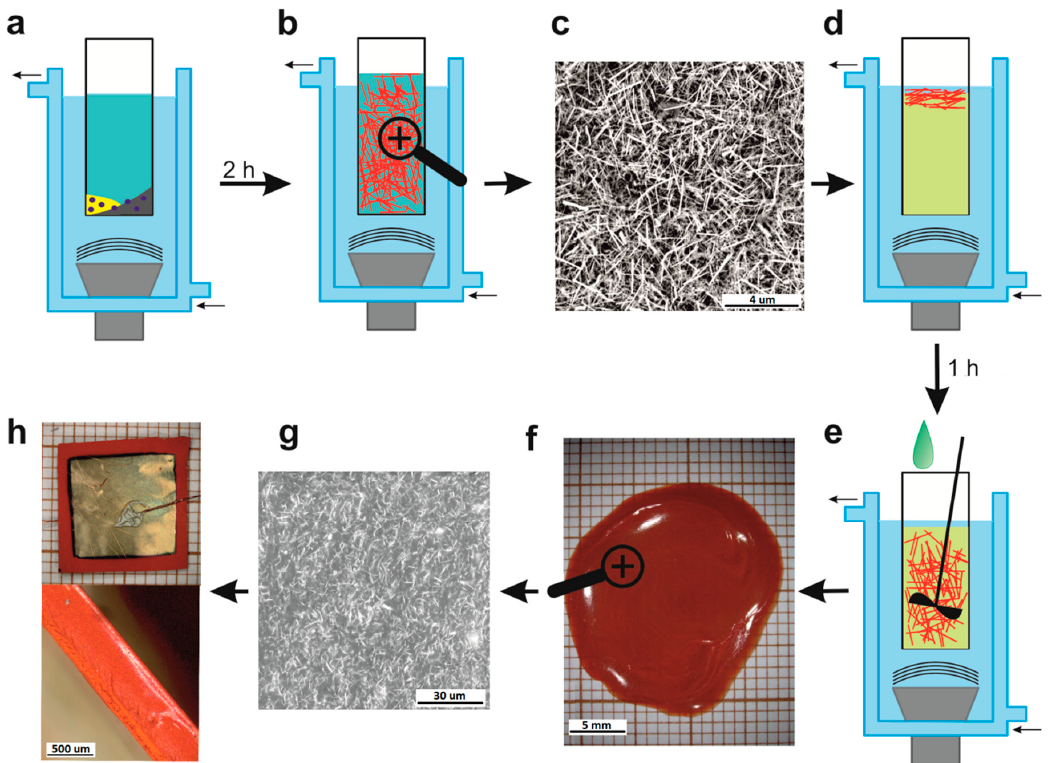
Figure 1. Scheme of sonochemical preparation of the epoxy resin/antimony sulpho-iodide (SbSI) nanowire composite and epoxy resin/SbSI nanowire generator/sensor assembly. The steps are as follows: ( a ) initial elements (sulphur, antimony, and iodine) are sonicated in an ampoule filled with ethanol; ( b ) SbSI nanowires are obtained after 2 h of sonication; ( c ) a typical scanning electron microscopy (SEM) micrograph of the sonochemically prepared SbSI nanowires; ( d ) the epoxy resin and SbSI nanowires (rinsed eight times in ethanol) are sonicated together; ( e ) the addition of hardener to homogenise the mixture of epoxy resin and SbSI nanowires (mechanical and ultrasonic mixing for 5 minutes); ( f ) the obtained epoxy resin/SbSI nanowires composite plate; ( g ) SEM micrograph showing the composite’s morphology; and ( h ) a photo of the piezoelectric epoxy resin/SbSI nanowire generator/sensor (top: the surface with deposited gold electrode and attached electrical leads; bottom: the edge of